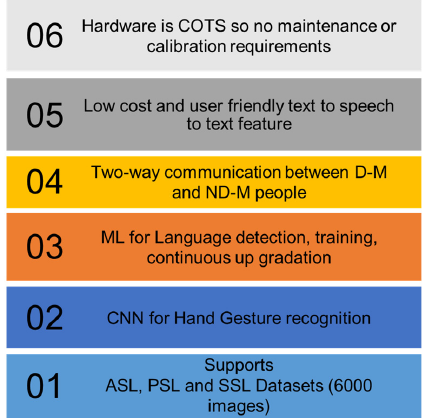
Figure 3. Novel features of the full duplex communication system.